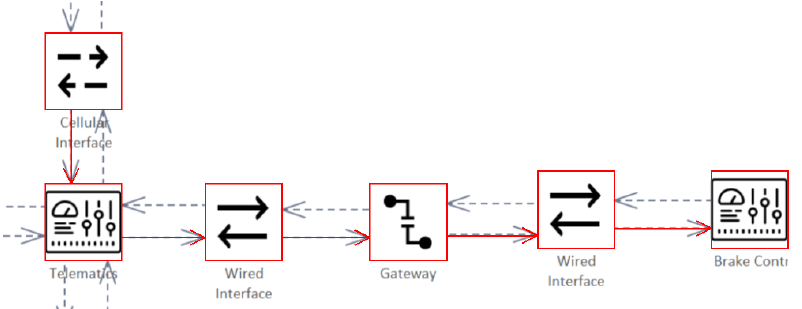
Figure 8. Attack path derived from flow